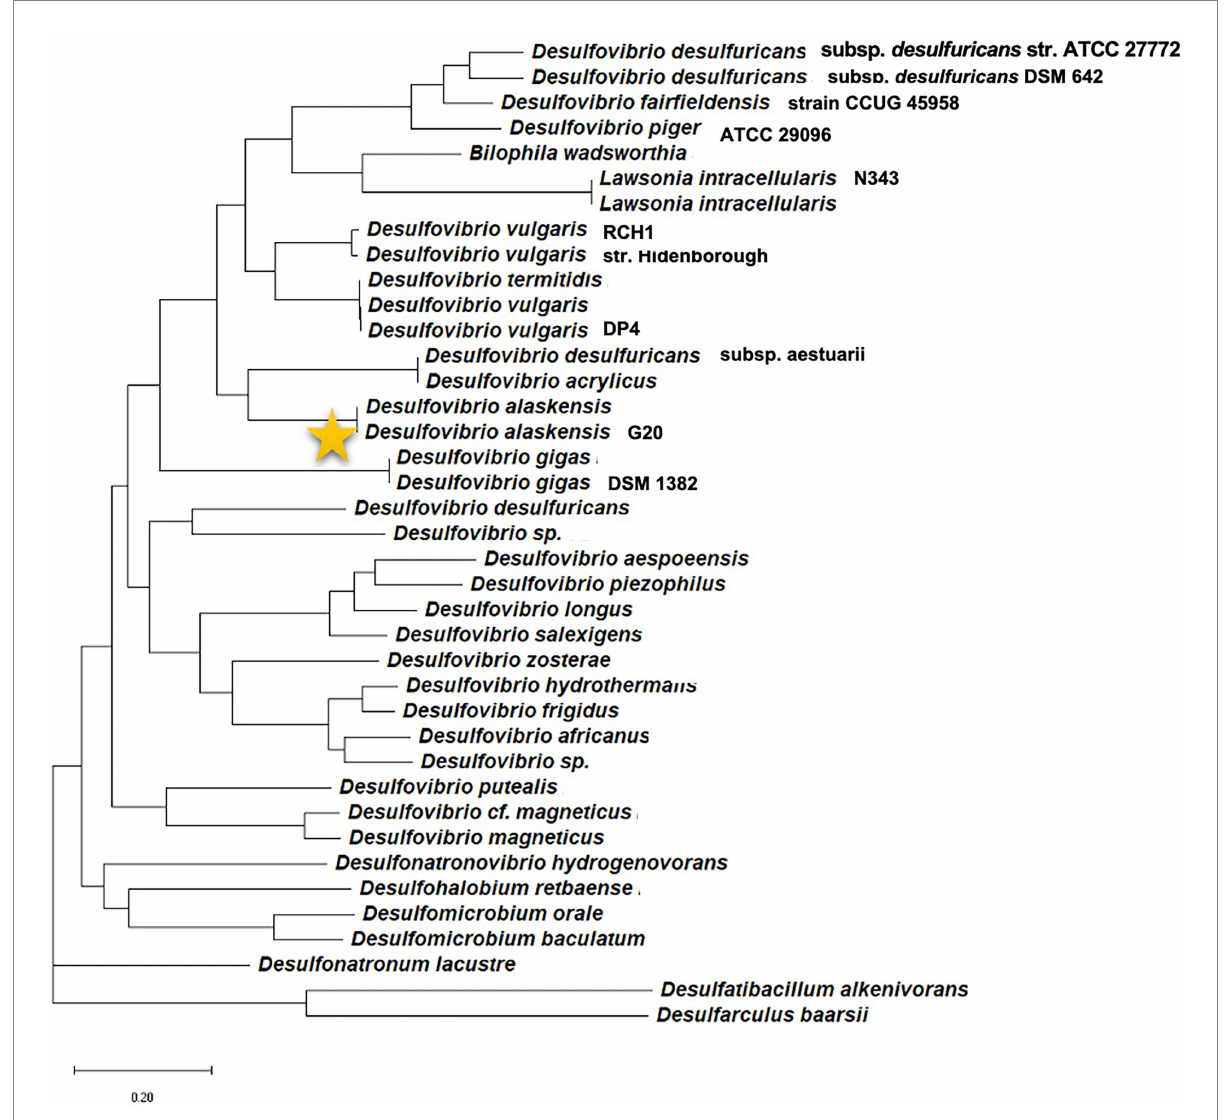
FIGURE 1 Phylogenetic position of the model organism Desulfovibrio alaskensis G20 among different sulfate reducing